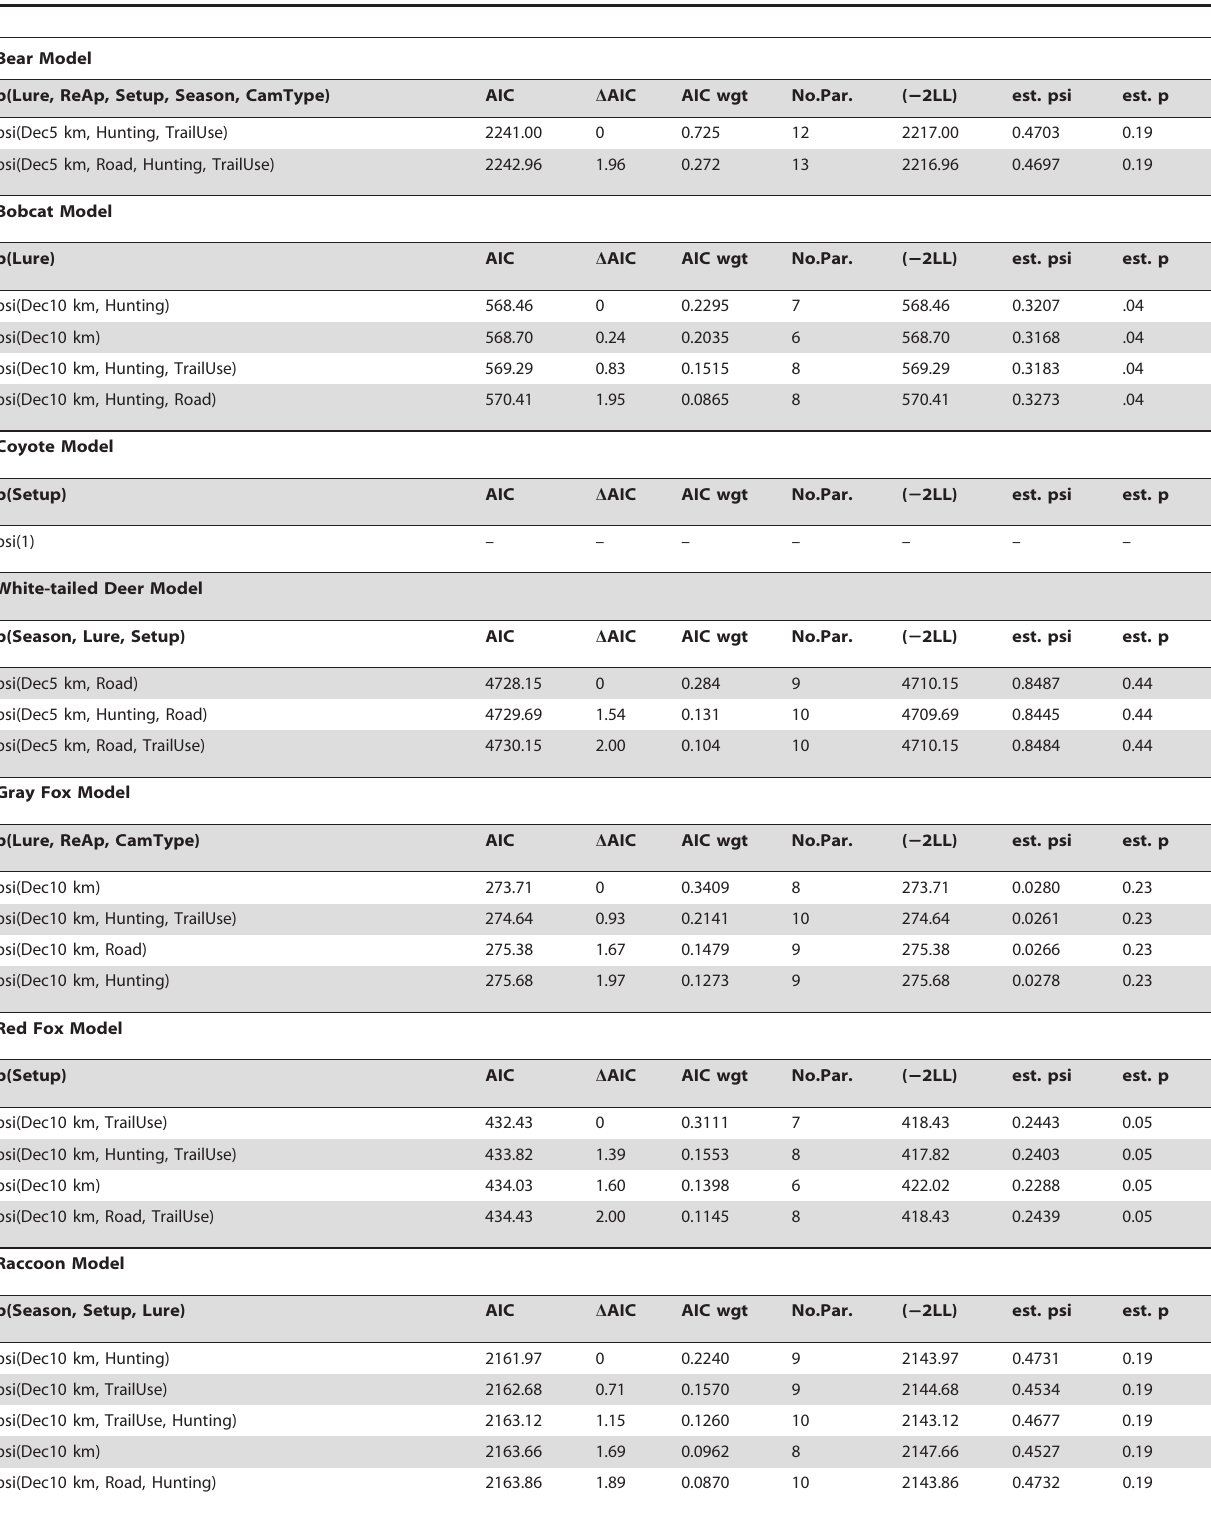
Table 3. Top logistic models for predicting the occupancy of eight mammal species within the Appalachian Trail corridor in 2007–